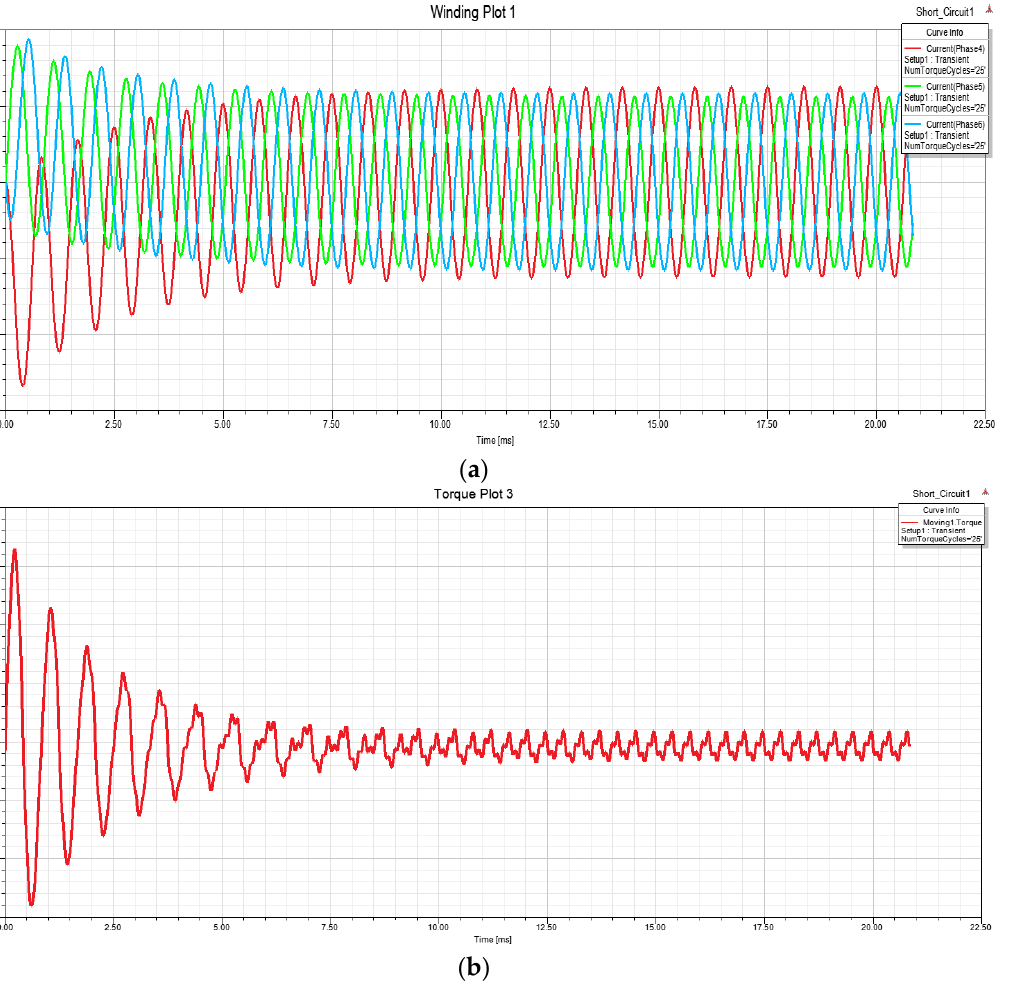
Figure 9. Short circuit behavior: ( a ) SC current in the fault phases; ( b ) output torque.